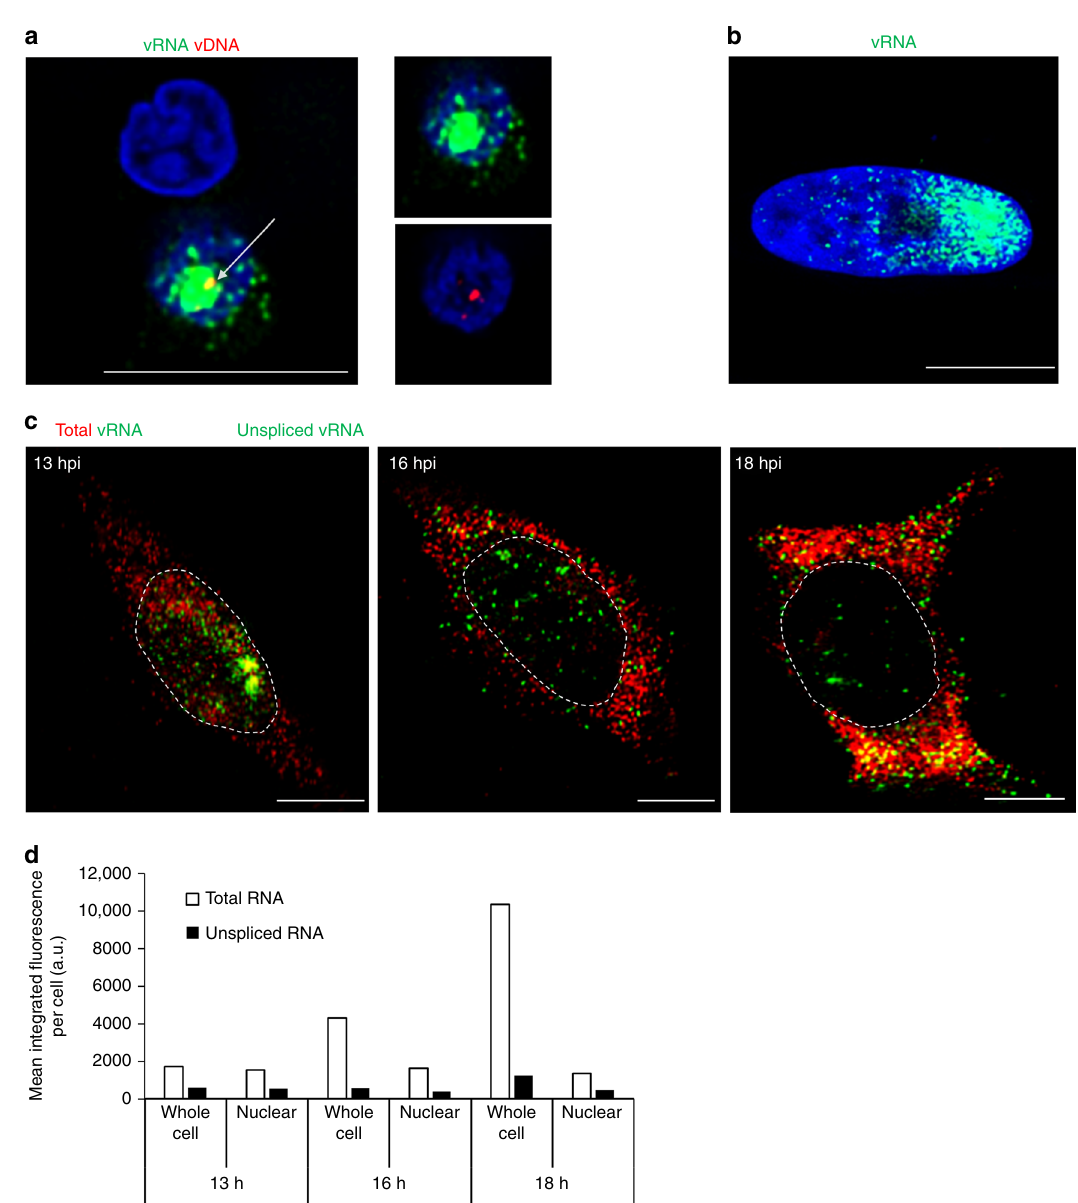
Fig. 4 Transcription and splicing of vRNA. a Nascent vRNA transcribed from nuclear vDNA in primary cells. Viral transcription site is indicated with a white arrow and appears in yellow because of newly formed vRNA (PS-2; green) and vDNA (PS-3; red) co-localization. Separate red and green channels are shown to the right. PBMCs were infected at an MOI of 0.2; at 48 hpi they were fi xed and stained. b HIV-1 transcriptional burst phenotype. TZM-bl cells were infected at an MOI of 0.2; at 12 hpi they were fi xed and stained with for unspliced vRNA (PS-1; green) and nuclei (blue). c Multiplex detection of total and unspliced vRNA informs temporal differences in localization. TZM-bl cells were infected with HIV-1 at an MOI of 0.5. At the indicated times, cells were fi xed and stained with PS-4 for total vRNA (spliced and unspliced; PS-4; red), unspliced vRNA (PS-1; green), and nuclei (outline). d Spliced and unspliced vRNA were quanti fi ed for the whole fi eld of view and within the nuclei. 200 – 300 cells per time point were analyzed using Gen5 software to measure the total fl uorescence signal (the sum of the pixel intensities) per cell, either in the complete fi eld of view (whole cell), or within a nuclear mask (nuclear). Scale bars represent 10 µ